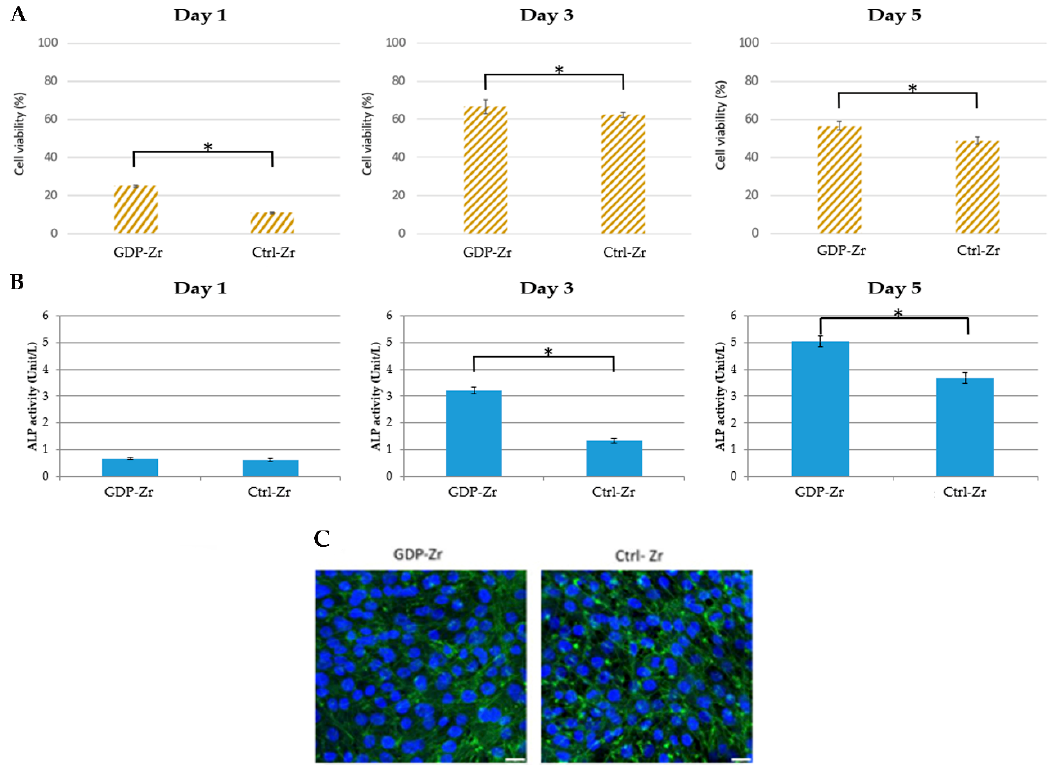
Figure 4. MG-63 cell proliferation on Zr disc surfaces. ( A ) MTT assay of MG-63 cells collected on various days to observe the cell viability on different surfaces. ( B ) Alkaline phosphatase assay (colorimetric) of MG-63 cells collected on various days to observe the alkaline phosphotase (ALP) activity * p < 0.05. ( C ) Confocal microscopy observations of MG-63 cells on the treatment surfaces. Images of MG-63 cells on the treated Zr disks and plates at 24 h. Scale bar: 25 μ m. GDP-Zr: cells were seeded on GDP-treated Zr disks, Ctrl-Zr: cells on autoclaved Zr disks, Mock: cells on the plate.